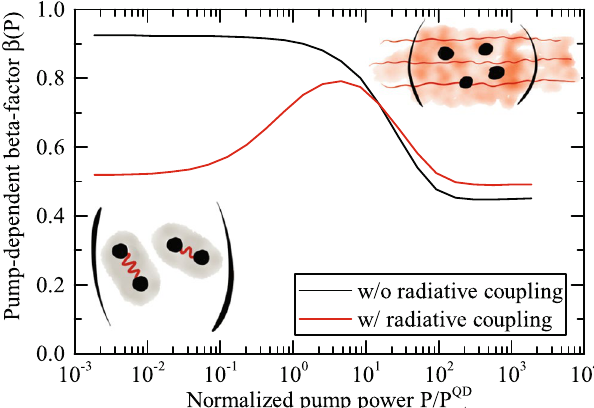
Figure 3. Pump-rate dependent β -factor obtained from the theoretical model with parameters applicable to the experimentally studied system (red curve). Calculation suppressing radiative coupling effects between emitters that are responsible for sub- and superradiant effects (black curve). Comparing both curves reveals that radiative coupling effects lead to a strong inhibition of spontaneous emission at low excitation (i.e. subradiance) and a slight enhancement of spontaneous emission above the laser threshold (i.e.